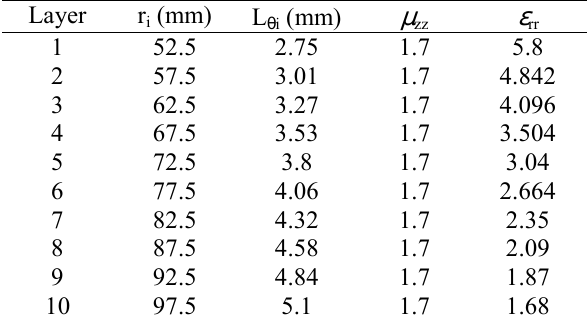
Table 1. The bulk metamaterial is assembled using 30 layers of RO3003 TM dielectric boards on which subwavelength resonant structures are printed. The layers are mounted 1 by 1 in a molded matrix with a constant angle of 3° between each. A commercially available liquid resin is then flowed into the mold. This resin constitutes the host medium and is an important design parameter which is closely linked to e qq . removed after solidification of the resin.